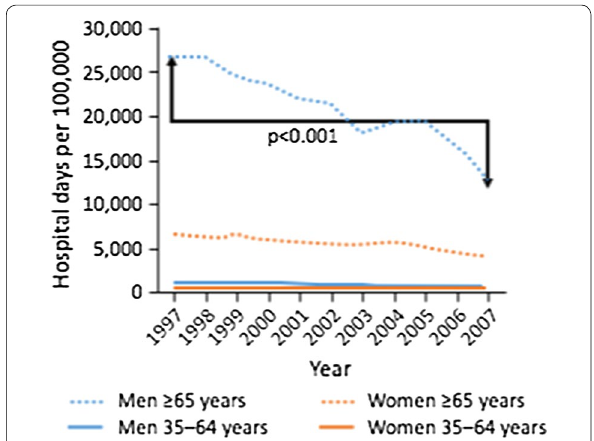
Fig. 2 Hospital admissions were reduced in Finland after initiation of the 10‑year COPD programme (from Kinnula et al.